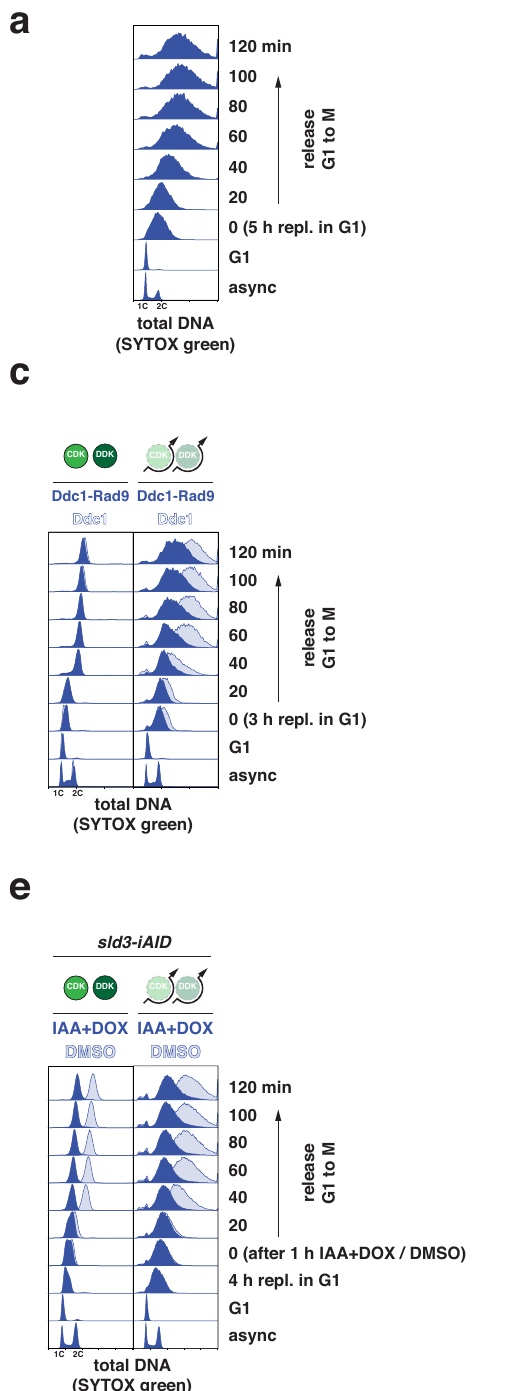
a Ddc1-Rad9 fusion protein as a second copy of Ddc1, which leads to hyper- sensitizedcheckpointcontrolsalsoduringG1replication. c Flowcytometrydataas in( a ); d westernblotsasin( b ).Dataarerepresentativeof n =2biologicalreplicates. e , f S-phase replication is required for DNA damage induction and checkpoint activation.Experimentasin( a , b )withstrainsharboringa sld3 -iAIDdegronalleleto conditionally induce Sld3 degradation and suppress further origin fi ring during S-phase release. Depletion of Sld3 was triggered by addition of 3mM auxin (IAA) and 20 µ g/ml doxycycline (DOX) in the last hour of G1 replication before release and suppressed DNA damage accumulation in and afterS-phase. e Flow cytometry data as in ( a ); f western blots as in ( b ). Data are representative of n =2 biological replicates. Source data are provided as a Source Data fi